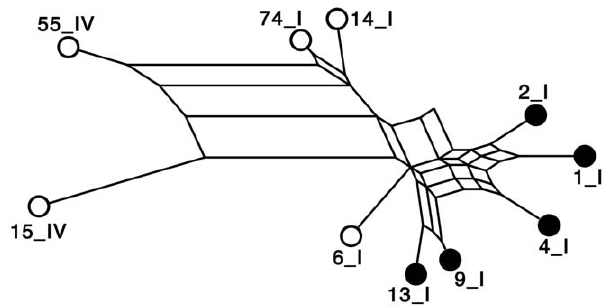
Figure 2. Network analysis of the relatedness of the fHbp amino acid sequence variants tested for JAR 1 binding. The network analysis was generated by the program, Splits Tree [33]. All sequence variants were in variant group 1. Each variant is designated by its peptide ID number as described in the public fHbp sequence variant database (http://pubmlst.org/neisseria/fHbp/) followed by Roman numeral I or IV, which designates the fHbp modular group [20,21]. Sequence variants represented by filled black circles were positive for binding to JAR 1; sequence variants represented by open circles were negative for binding to JAR 1 (See Figure 1). Panel C), which has His at position 204 instead of Arg. Although JAR 1 to fHbp ID 1 (R204A), substitution of His for Arg at residue 204 of ID 1 did not affect JAR 1 binding (R204H, Figure 3, Panel D).